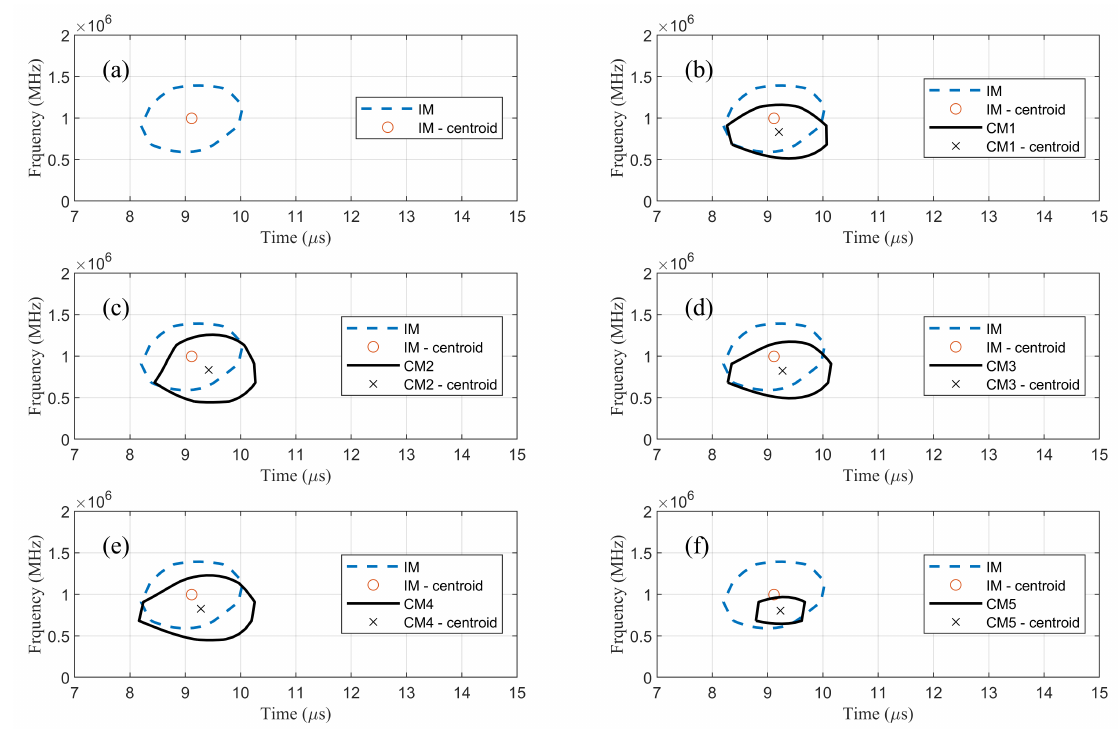
Figure 9. Half-power contours of the first wave packet at receiver R